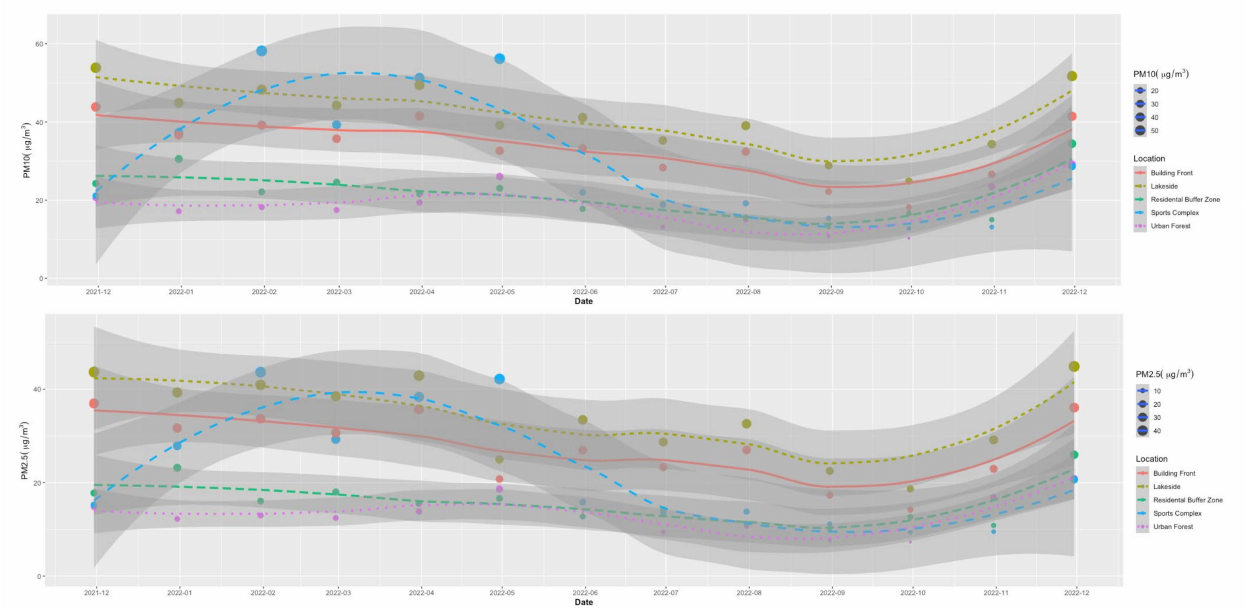
Figure 8. Time-series analysis of PM 10 and PM 2.5 concentration levels at the five locations using monthly average values.